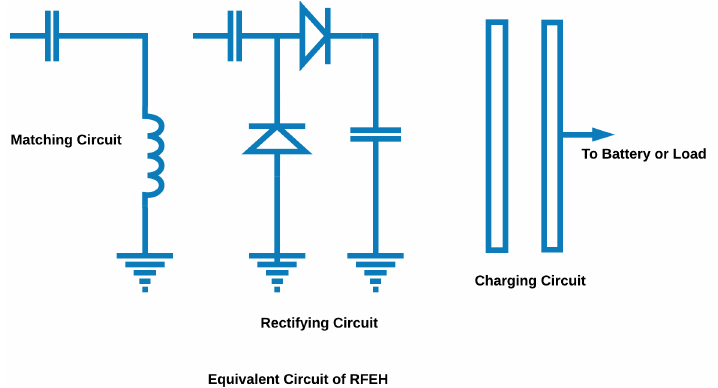
Figure 16. Electrical Equivalent Circuit of RF Energy